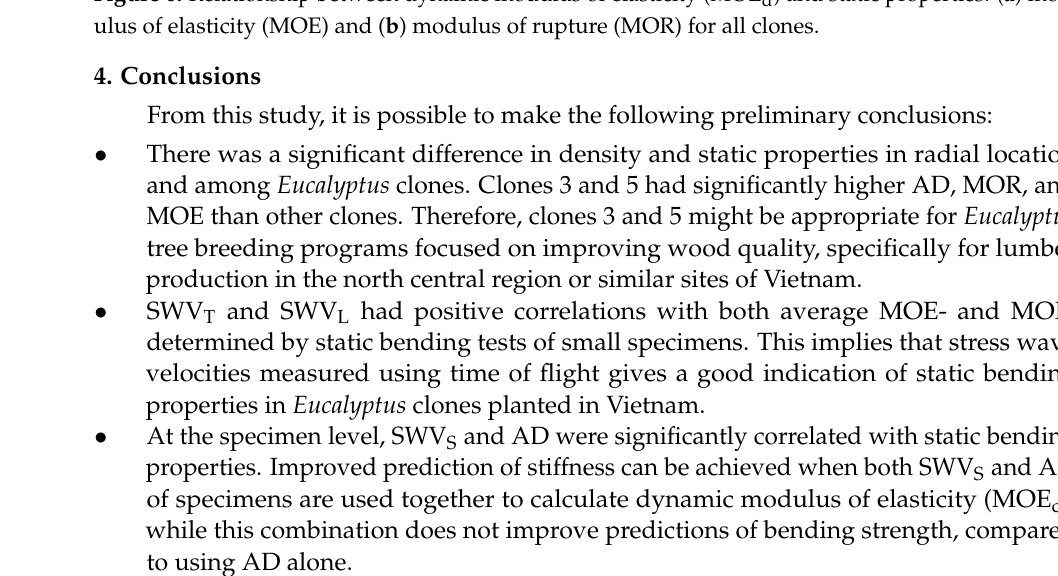
Figure 6. Relationship between dynamic modulus of elasticity (MOE d ) and static properties: ( a ) modulus of elasticity (MOE) and ( b ) modulus of rupture (MOR) for all clones.